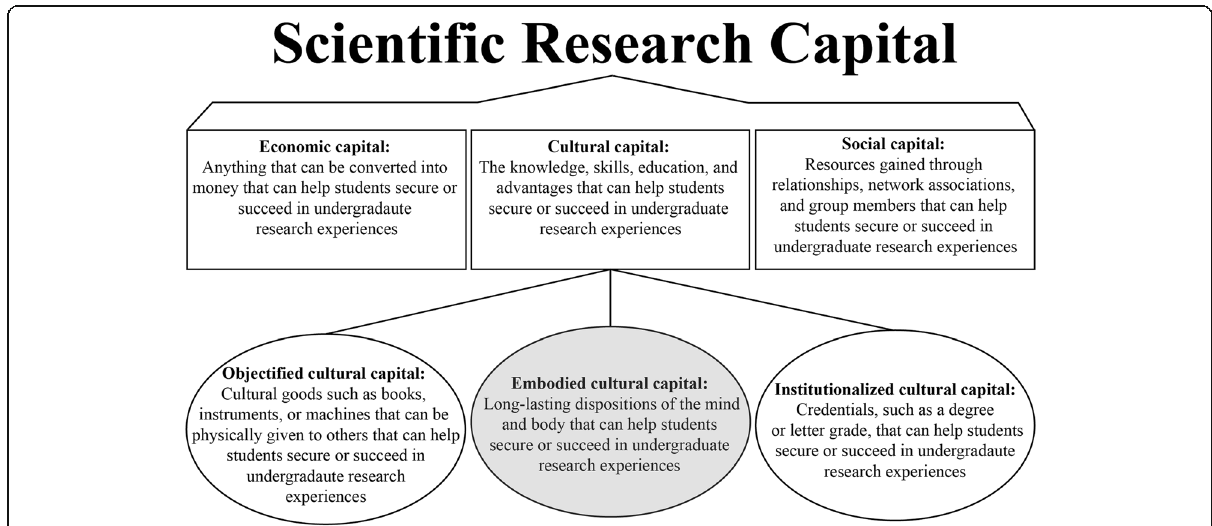
Fig. 2 Scientific research capital describes capital that influence students ’ paths to engaging in undergraduate research, as well as how students can succeed in their experiences in undergraduate research. It is comprised of economic, cultural, and social capital as described in the squares. There are three types of cultural capital — objectified, embodied, and institutionalized — as described in the circles. The focus of this study, embodied cultural capital, is